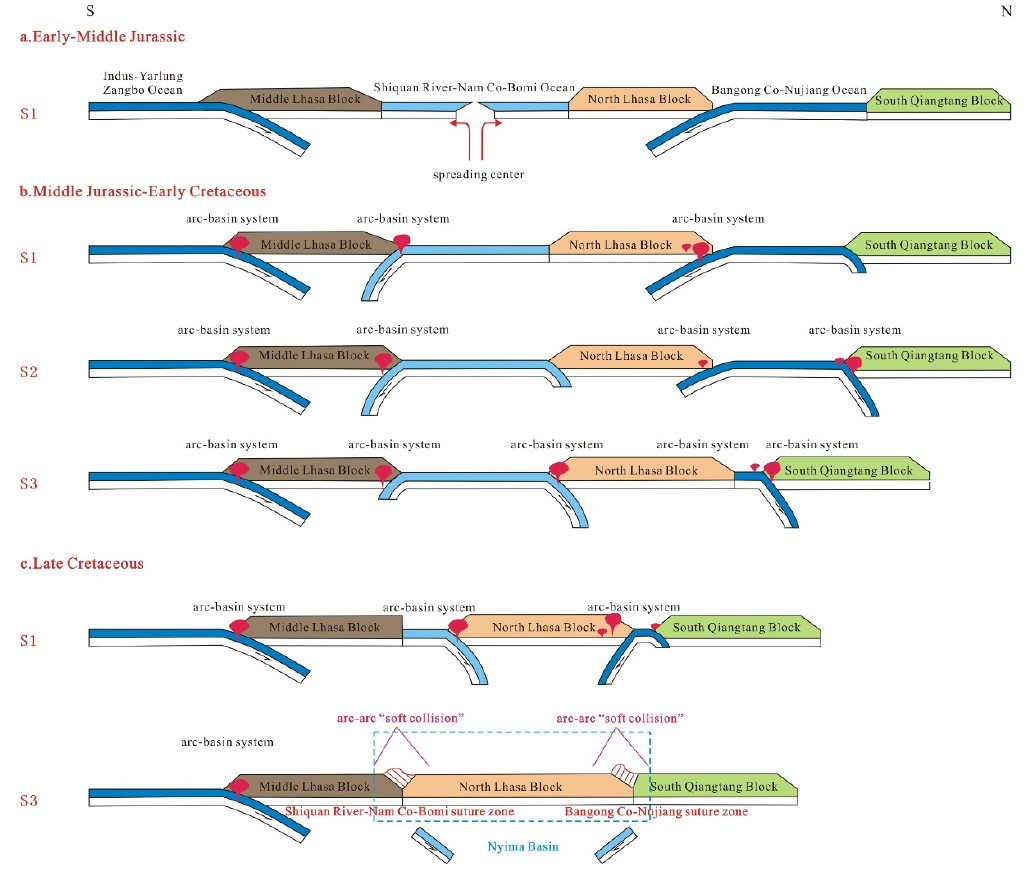
Figure 17. Formation and tectonic evolution of the Nyima Basin during the Early Jurassic to the Late Cretaceous.